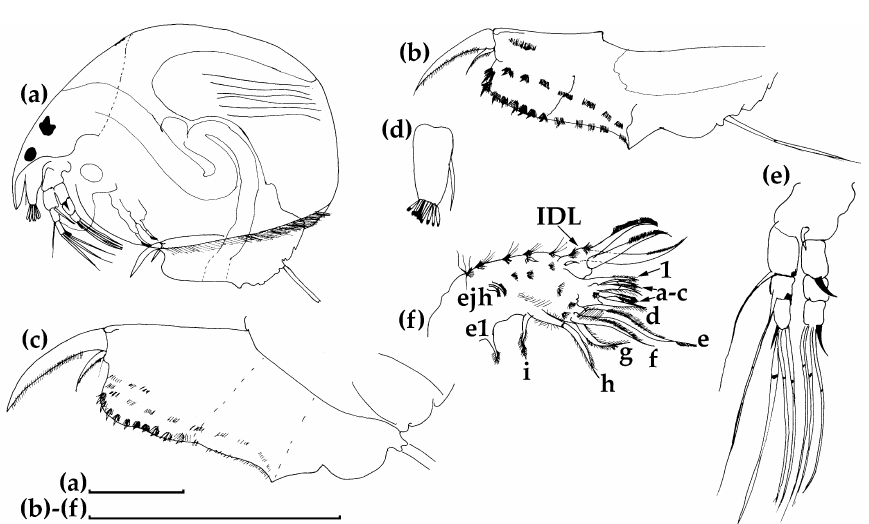
Figure 17. Coronatella anemae , an adult parthenogenetic female from Wadi Maidaq — Blue Pool, United Arab Emirates. ( a ) Female, lateral view; ( b , c ) postabdomen; ( d ) antenna I; ( e ) antenna II; ( f ) thoracic limb I. All scale bars: 0.1 mm.